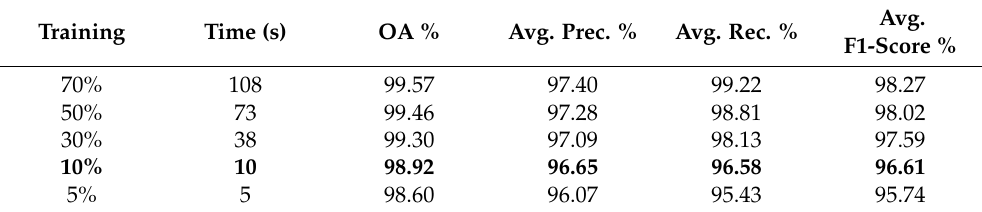
Table 6. Comparison of different sizes of training dataset using six features ( NH , dZ , P λ , M 22, M 21, Vert ). Bold values are close to 99% overall accuracy.